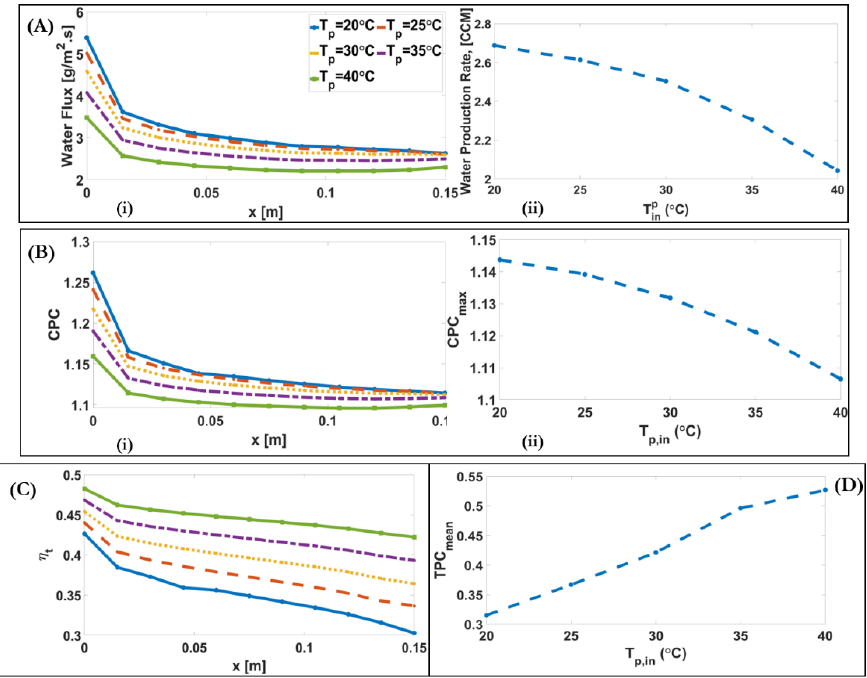
Figure 8. ( A ) ( i ) Downstream alterations of water flux for different inlet permeate temperature of a DCMD system; ( A ) ( ii ) Alteration of water production rate with varying inlet permeates temperatures of a DCMD system. ( B ) ( i ) Downstream alterations of CPC for different inlet permeate temperatures of a DCMD system; ( B ) ( ii ) Alteration of maximum CPC with varying inlet permeate temperatures of a DCMD system. ( C ) Downstream alteration of 𝜂 𝑡 for different inlet permeate temperatures of a DCMD system. ( D ) Alteration of mean value of TPC with varying inlet permeate temperatures.